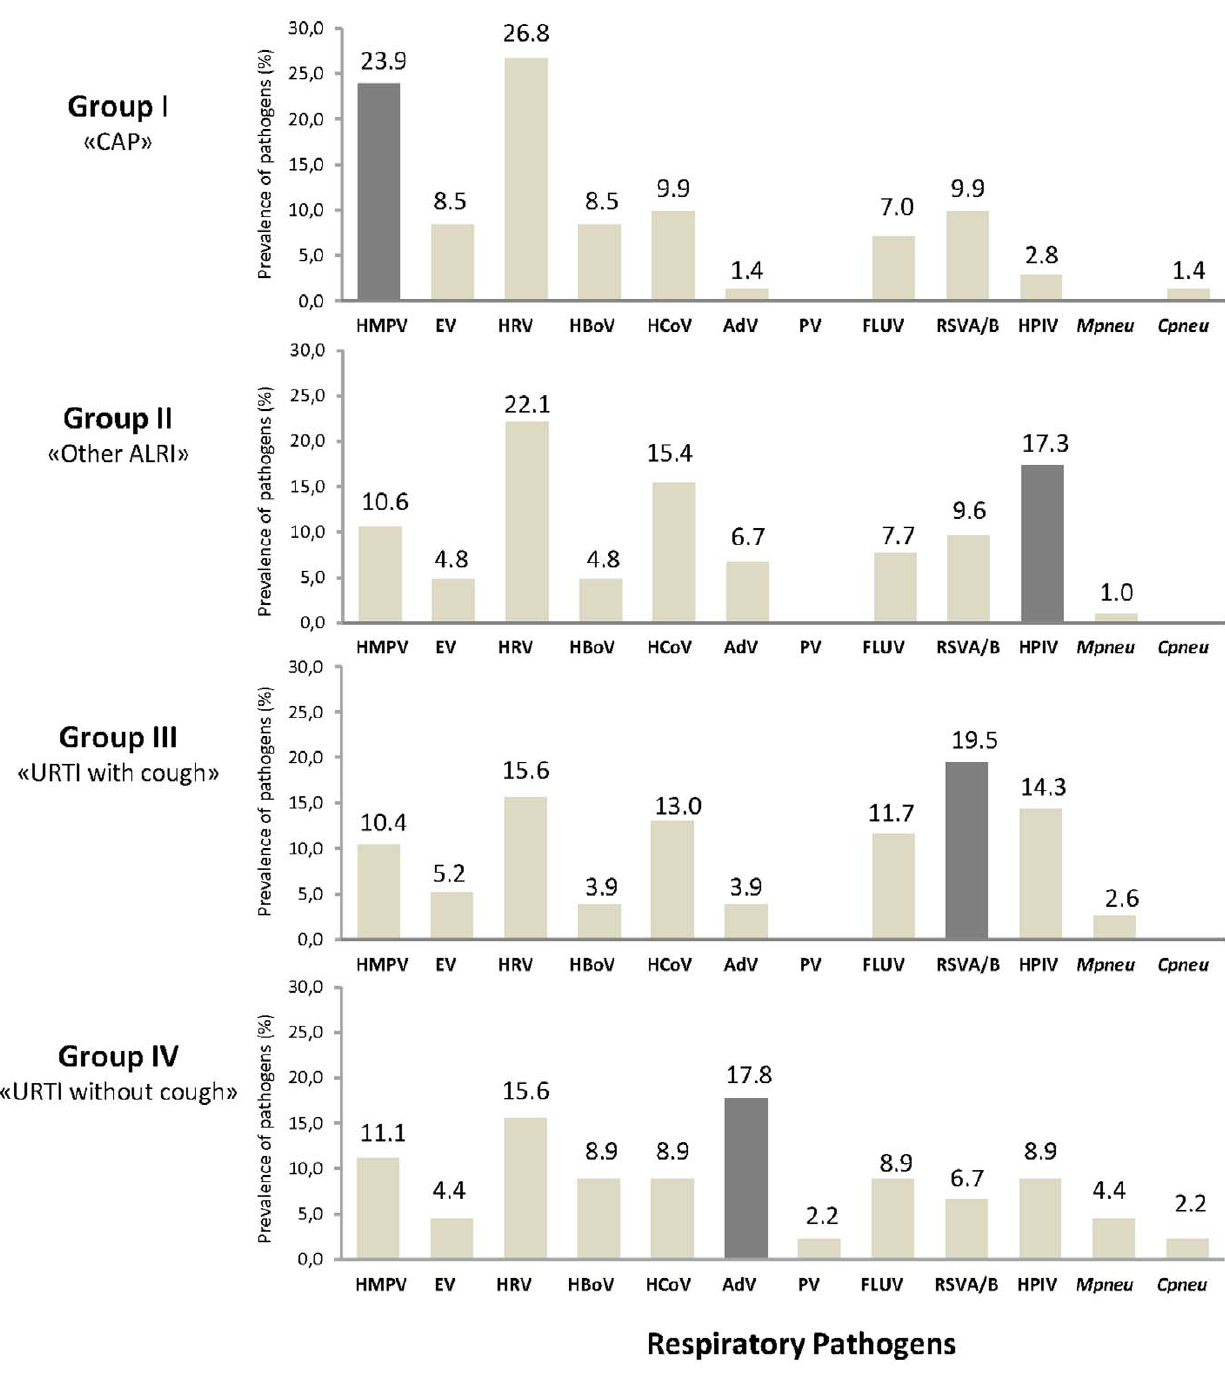
Figure 1. ARIs viral and atypical bacterial etiologies related to clinical manifestation groups. All 295 acute respiratory infection episodes were classified in 4 clinical manifestation groups (Group I, n=83; Group II, n=95, Group III, n=66; group IV, n=51 cases). The respiratory pathogens number upon the bar represents the percentage of the total pathogens identified in each clinical group. The dark grey bars correspond to the significant association ( P =0.05) between the pathogen and the clinical group.